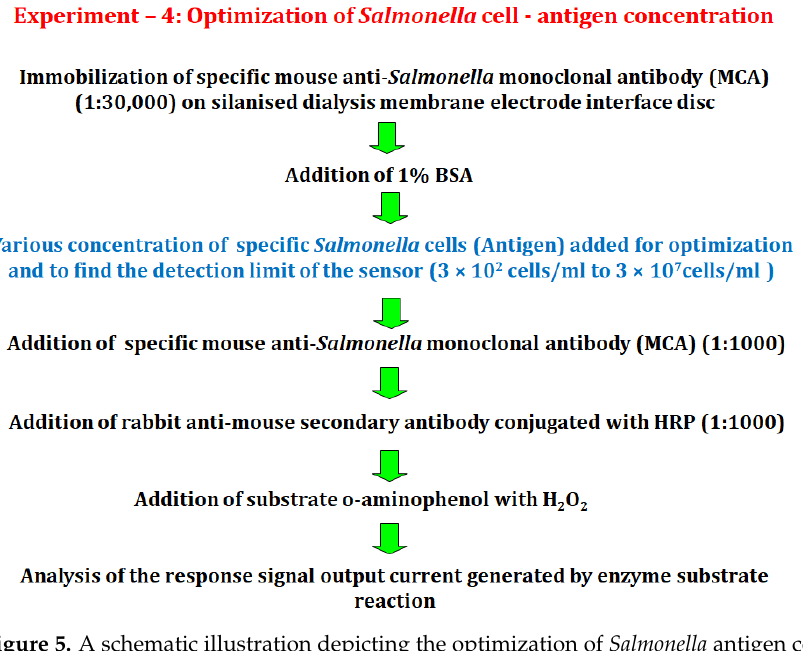
Figure 4. Schematic diagram showing optimization of mouse anti- Salmonella monoclonal antibody (MCA) concentration for the detection of Salmonella cells.